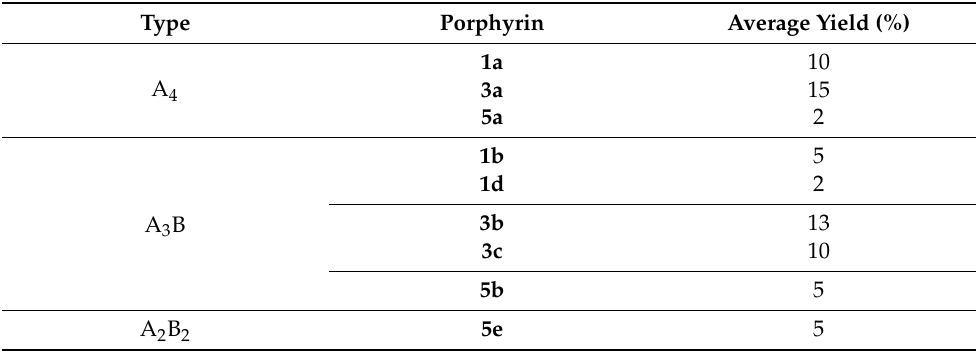
Table 2. Average yields of porphyrin